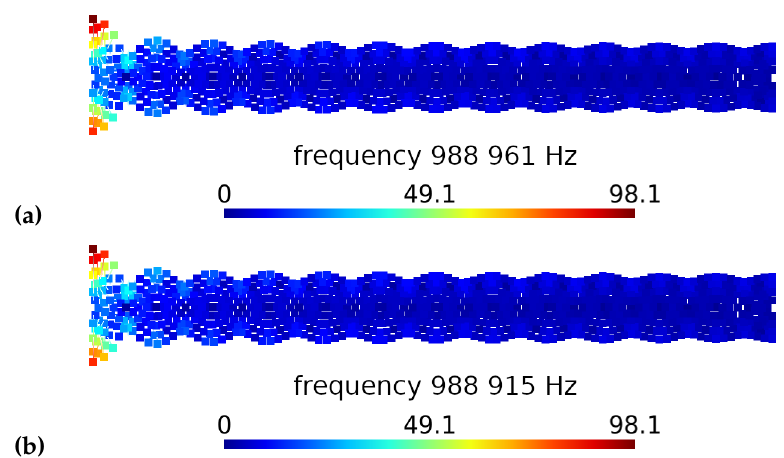
Figure 4. Oscillation shape and frequency for mesh variant ( a ), for mesh variant ( b ). Half of the resonator cross section is shown, and the center of the resonator is on the left. The shape of the oscillation corresponds to the shape of the thickness oscillation in Section 5.3 in [1]. The calculated resonance frequencies are f ra = 988,961 Hz for mesh variant (a), f rb = 988,915 Hz for mesh variant